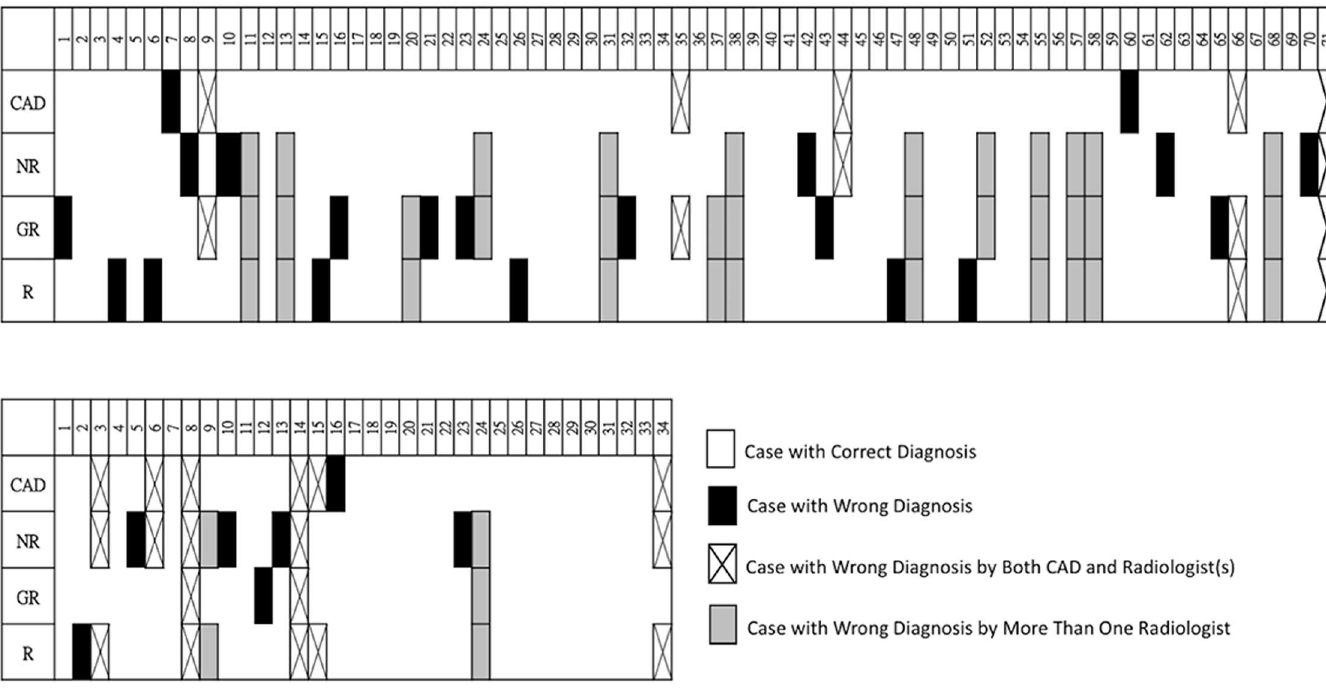
Fig 4. Complete list of misdiagnosed cases in both the low-grade glioma (LGG; upper row) and glioblastoma (GBM; lower row) groups. Misdiagnosed cases are marked in the figures. Many cases were misdiagnosed by more than one radiologist,especiallyin the LGG group (gray color). (CAD, computer-aided diagnosis; NR, neuroradiologist; GR, generalradiologist;R,